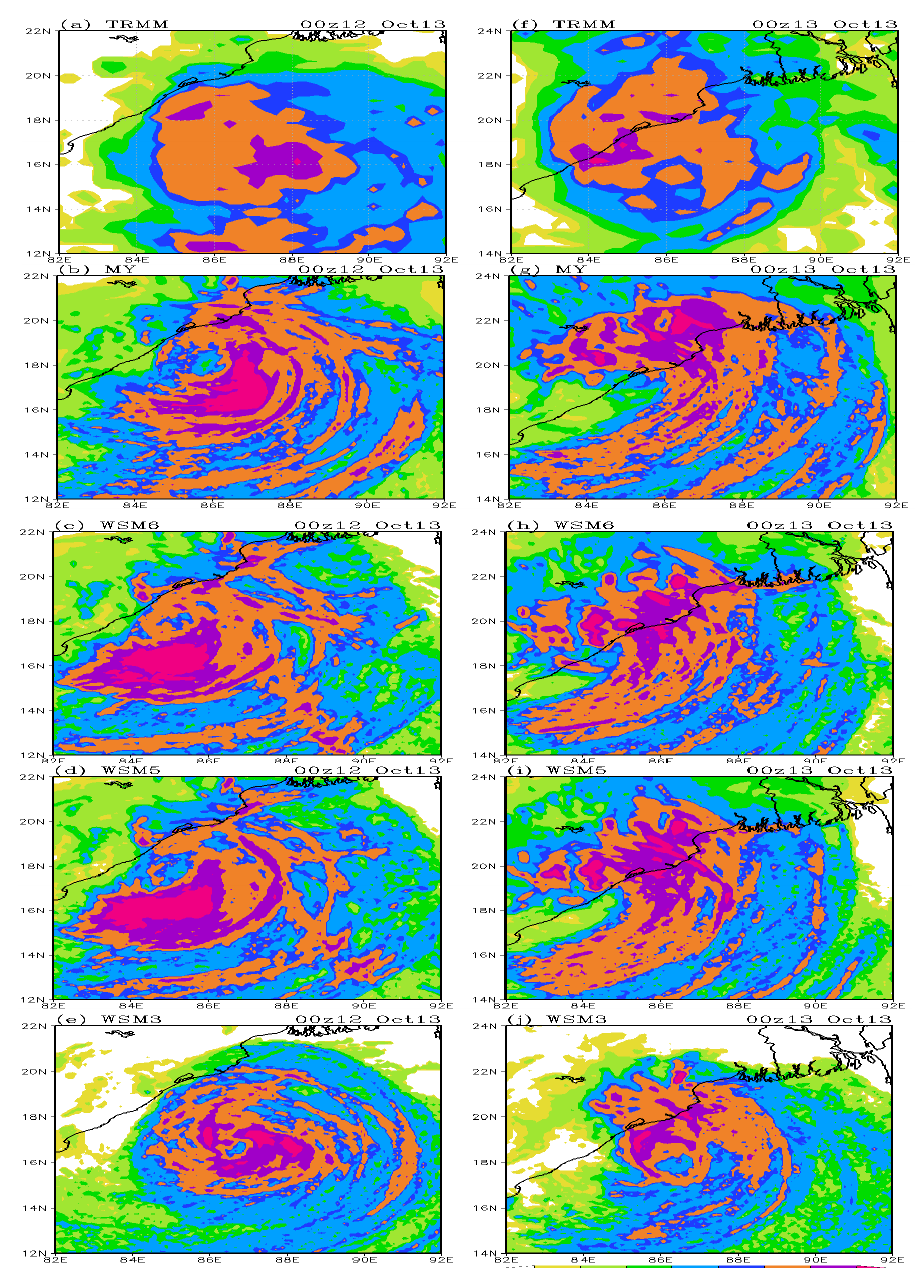
Figure 11. Comparison of 24 h accumulate precipitation (mm·d − 1 ) of Phailin at the ESCS stage de- rived from TRMM 3B42 satellite ( a ) and WRF model experiments using ( b ) MY, ( c ) WSM6, ( d ) WSM5, ( e ) WSM3 schemes, valid at 00 UTC, 12 October 2013 at D02 resolution; figures ( f – j ) are the same as (a–e), but valid at 00 UTC, 13 October 2013 respectively.